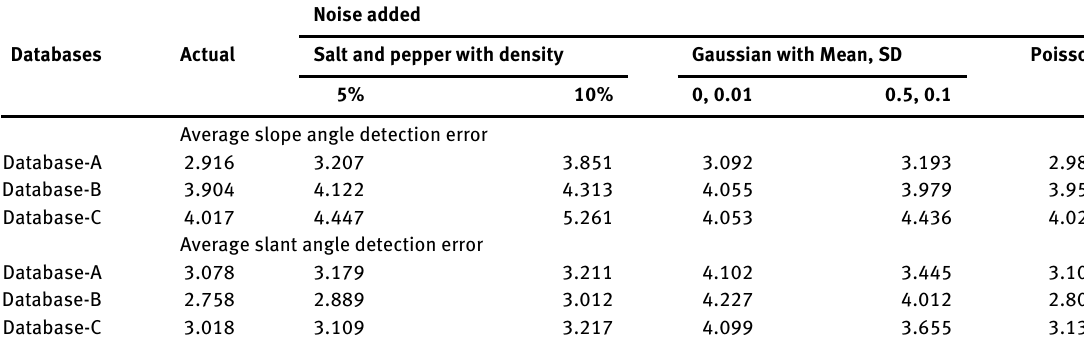
Table 2: Performances on Noisy Word Samples.